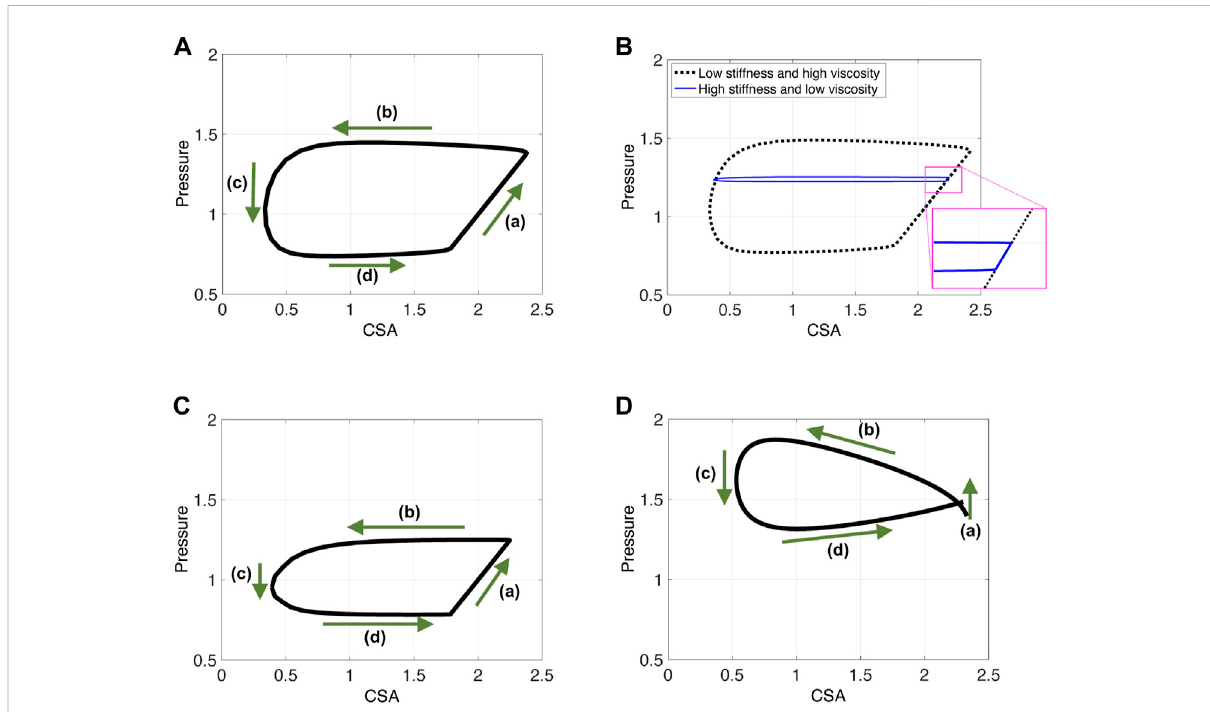
FIGURE 6 P-CSAplotsobtainedfromthreedifferentcontractioncyclesimulations.InputparametersareaslistedinTable1and ψ =100. (A,B) TheFLIPbag does not pass through the LES, w = .25, (C) the FLIP bag passes through the LES, w = .25, and (D) simulation results for a short FLIP bag, w =